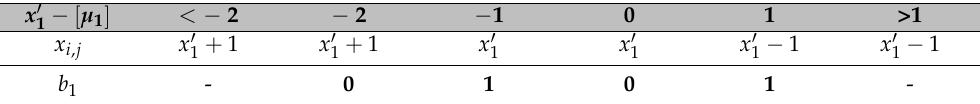
Table 1. S-PEE extraction and recovery